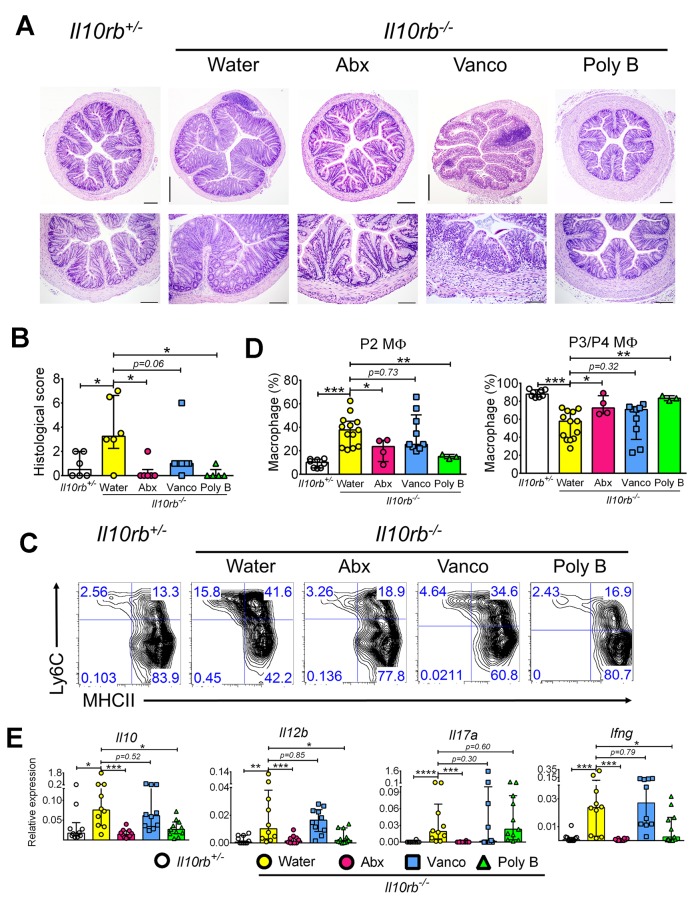
Antibiotics exposure prevents colitis in infant Il10rb-/- mice.(A) Representative histological images (4X magnification in upper panel, scale = 500 μm; 10X in lower panel, scale = 200 μm for Il10rb+/-, Il10rb-/- Water, and Poly B; and 20X in lower panel, scale = 100 μm for Abx and Vanco) of distal colons from 4 week old Il10rb-/- or control mice exposed to regular water or indicated antibiotics. (B) Summary of histological scores from 4 to 6 mice. (C) Representative FACS plots of colonic LP MΦ populations, (D) Frequencies of LP MΦ subsets in the colons of mice described in C. (E) Gene expression analysis by qRT-PCR from the colons of mice indicated above. *p<0.05, **p<0.01, ***p<0.001, ****p<0.0001, Mann-Whitney U test. Data were pooled from mice (n = 3–11) obtained from 2 to 3 independent experiments. Poly B, polymyxin B; Vanco, vancomycin.